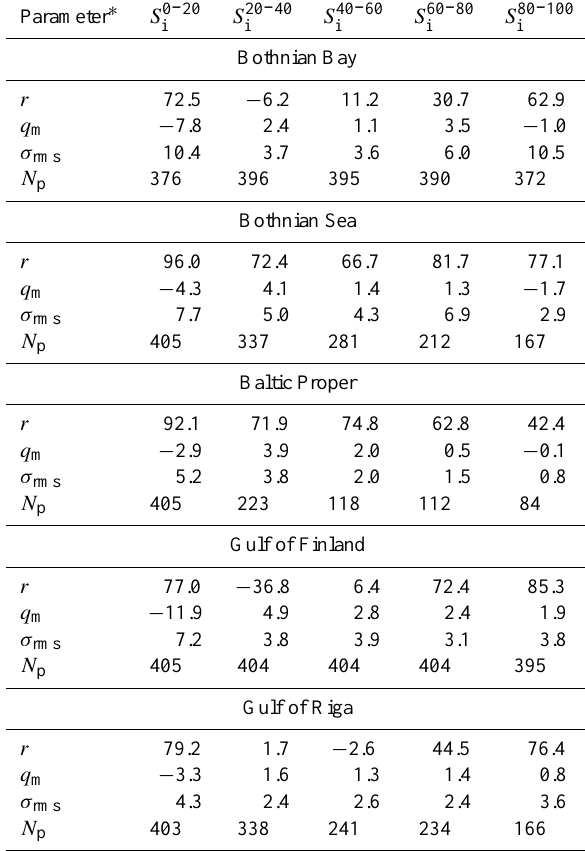
∗ r (%): correlation coefficient; q m ( 10 3 km 2 ): mean difference between the observa- tions and the model; σ rms ( 10 3 km 2 ): standard deviation of differences between the observations and the model; N p : number of data